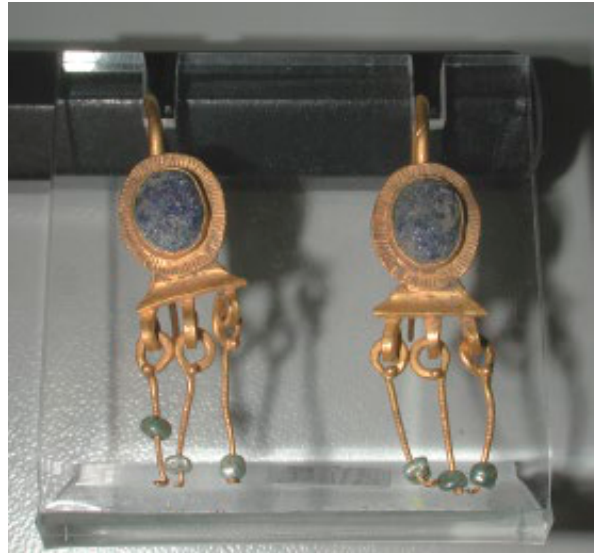
Figure 1. Earrings attributable to the Roman Imperial